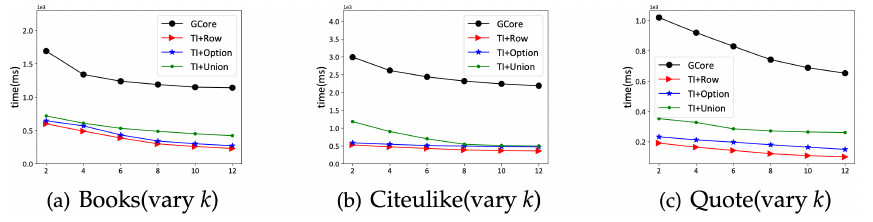
Figure 6. Effect of k in ( k , ω ) -core queries.